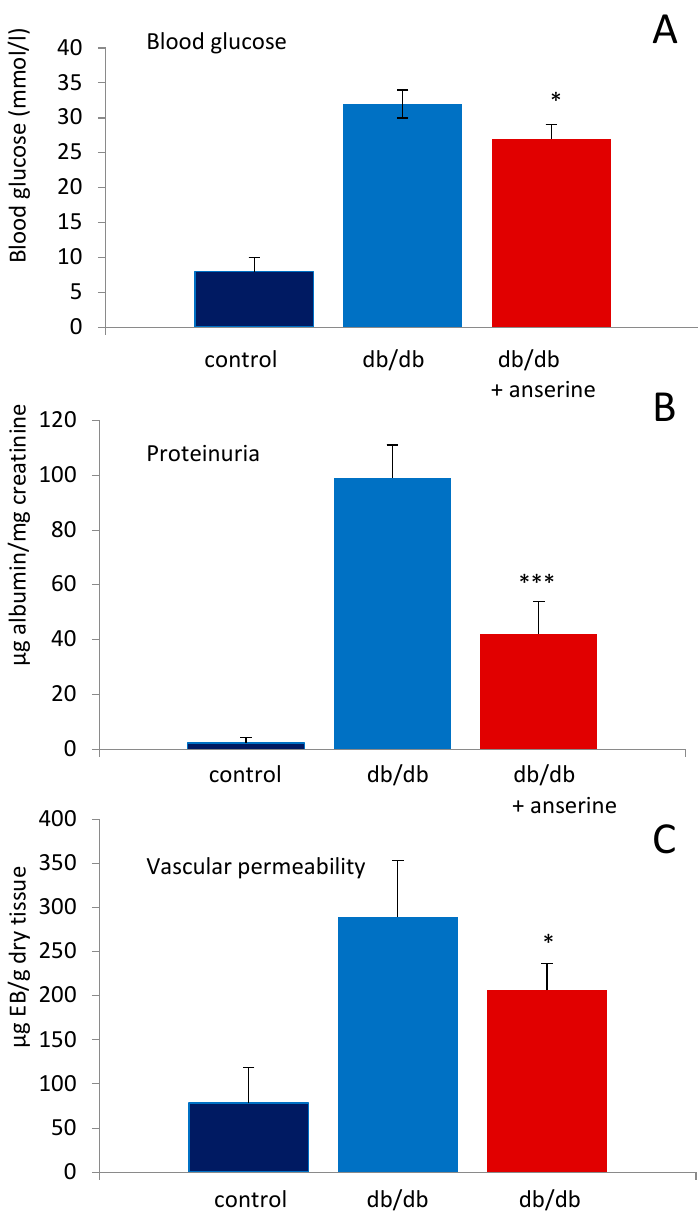
Figure 5. Effects of anserine on blood glucose, proteinuria and renal vascular permeability in diabetic mice (db/db). Twelve-week-old db/db were treated with three intravenous anserine injections every other day and scarified at week 14. Anserine treatment lowered blood glucose ( A ), proteinuria ( B ) and vascular permeability ( C ). p < 0.05 (*); p < 0.001 (***)